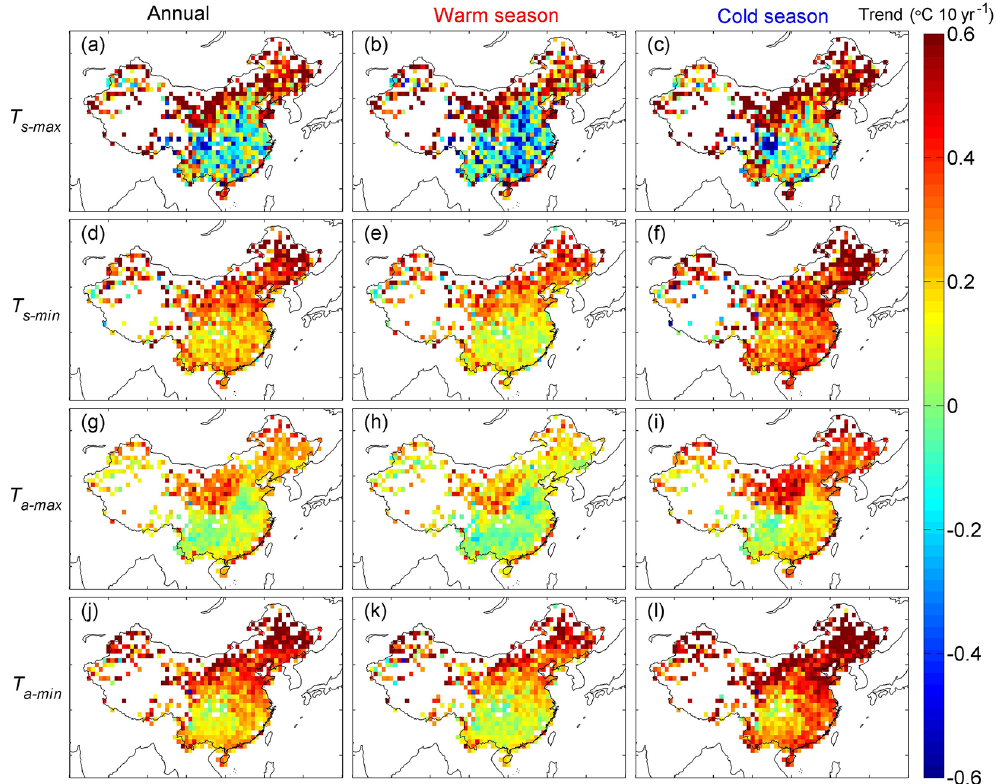
Figure 4. Maps of the trends of the monthly anomalies for daily maximum land surface temperature ( T s-max , (a–c) ), daily minimum land surface temperature ( T s-min , (d–f) ), daily maximum air temperature ( T a-max , (g–i) ), and daily minimum air temperature ( T a-min , (j–l) ) for the annual, warm (May–October), and cold (November–next April) seasonal scales. All trends reported here were calculated using a linear regression based on the least-squares